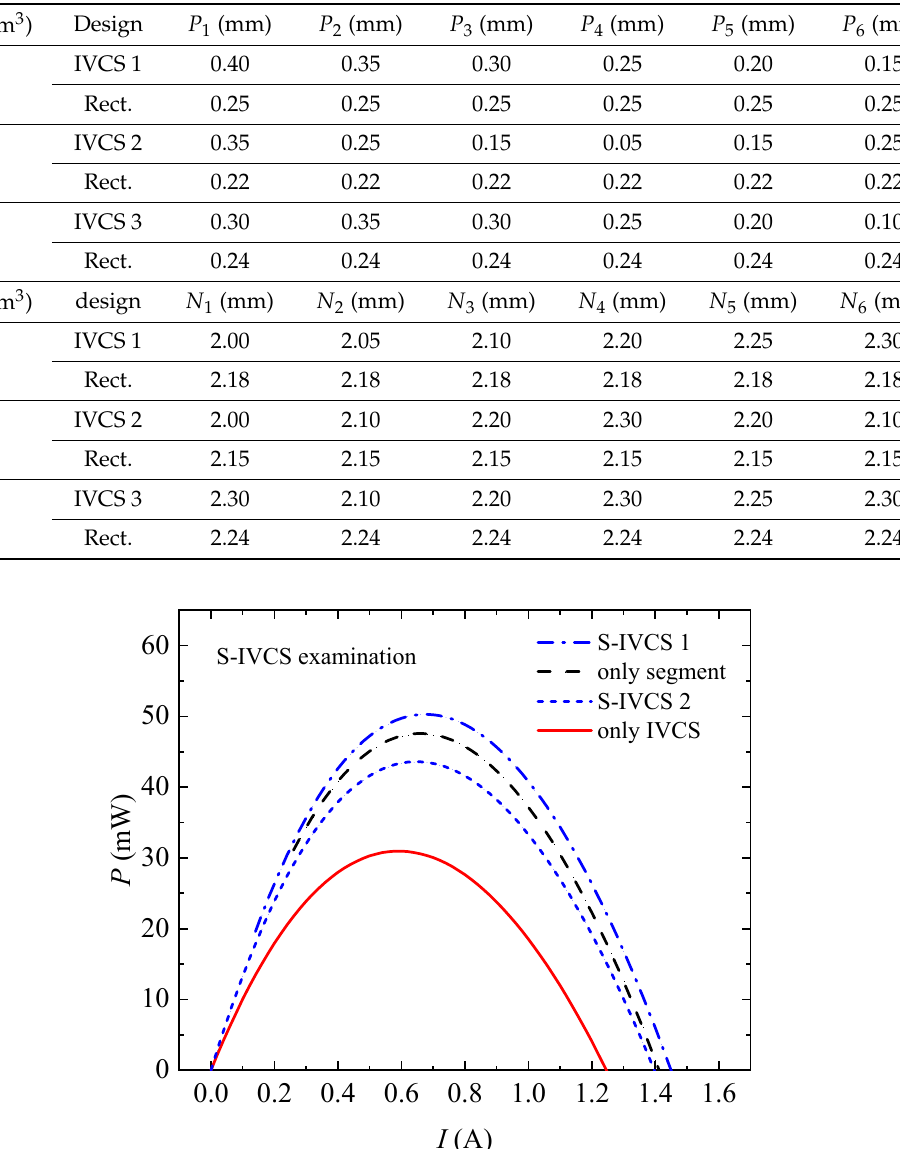
Table 2. Design parameters of the three IVCS patterns shown in Figure 5.